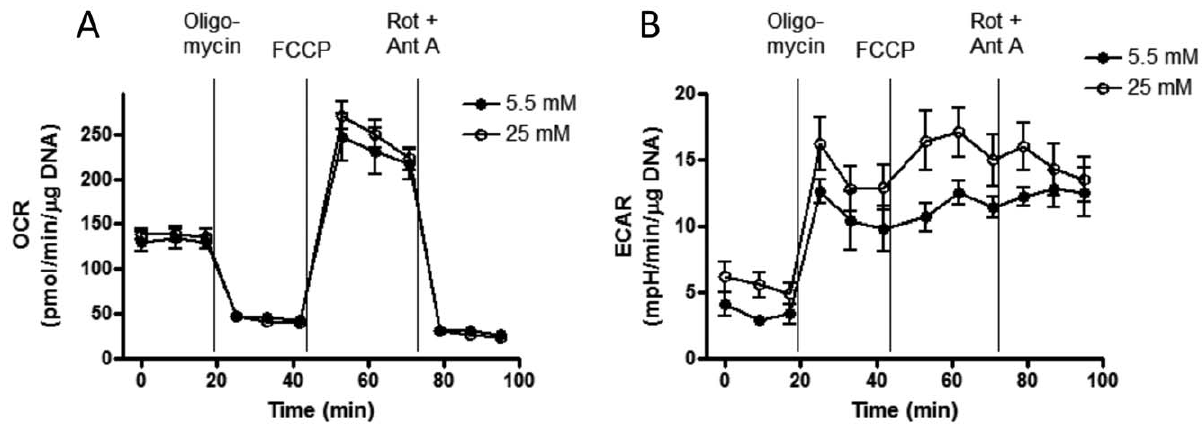
Figure 1. Oxygen consumption (OCR) and simultaneous rates of extracellular acidification (ECAR) by BAE cells exposed to differing glucose concentrations. Cells were exposed to 5.5 (closed circles) or 25 (open circles) mM glucose for 18 h prior to the experimental run with the same concentrations continued during the run. A) Representative experiment depicting OCR determined before (beginning time 0) and after sequential injections of the indicated compounds; oligomycin (2 m M), FCCP (2 m M), or antimycin A (Ant A, 0.5 m M) plus rotenone (Rot, 2 m M). B) Simultaneous ECAR measurements. Data show the mean 6 SEM of 5 values determined for each data point for each glucose condition. Quantitative results of this and other experiments are listed in tables 1 and 2.